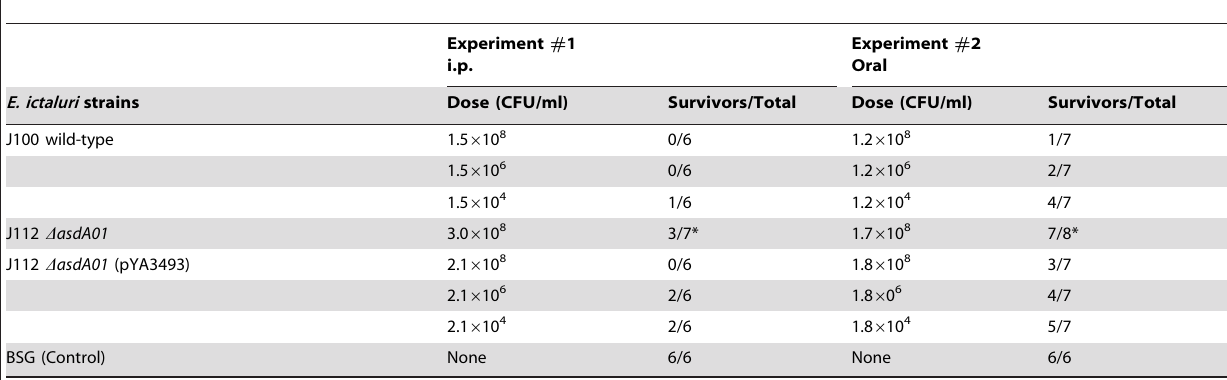
Table 4. Survival of catfish ( I. punctatus ) infected with E. ictaluri wild type and E. ictaluri D asdA01 with and without Asd + vectors.